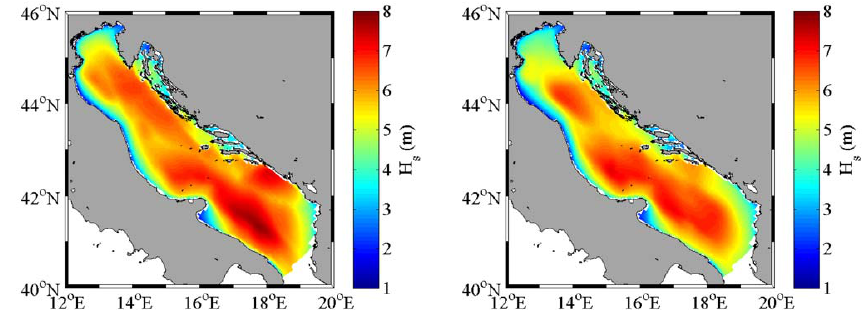
Fig. 9. Maximum H s (in meters). Numerical simulations of the present climate (left) and the future scenario (right) are shown.